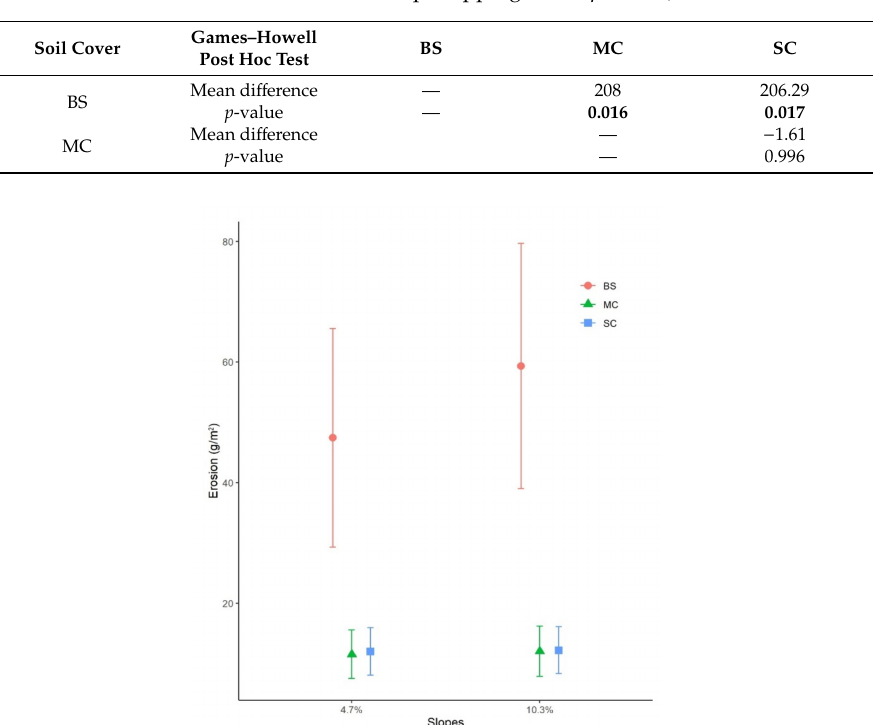
Figure 3. Mean of erosion rate in slopes characterized by di ff erent soil cover and slope steepness (mean ± standard error). Bare soil (BS), metal sieve cover (MC), and strip cropping